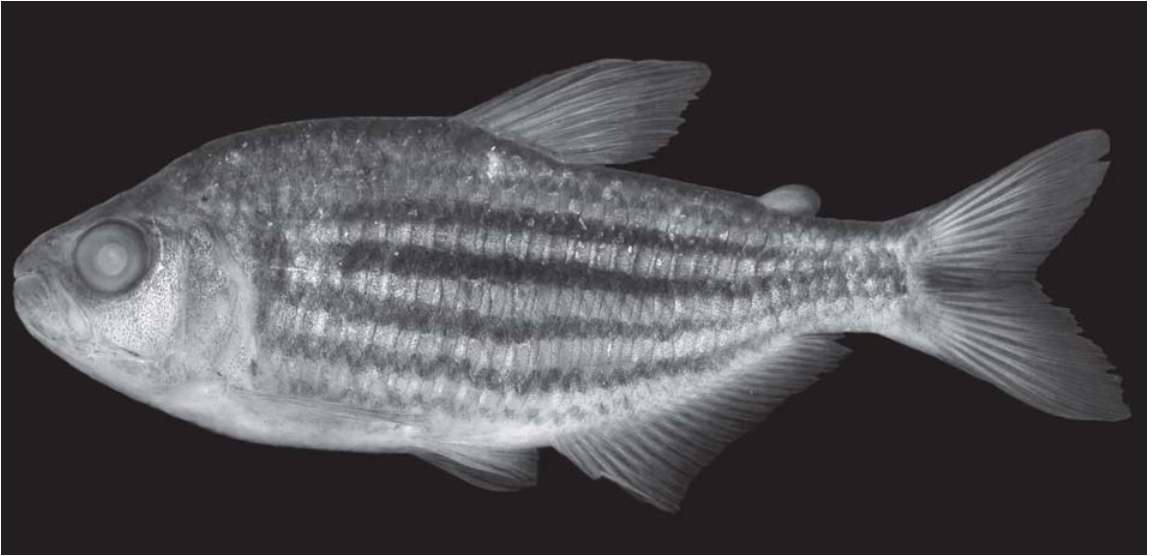
Fig. 1. Hyphessobrycon hexastichos , MCP 37648, holotype, 53.2 mm SL; Brazil, Mato Grosso, Comodoro, rio Mutum, tributary of rio Juruena, upper rio Tapajós